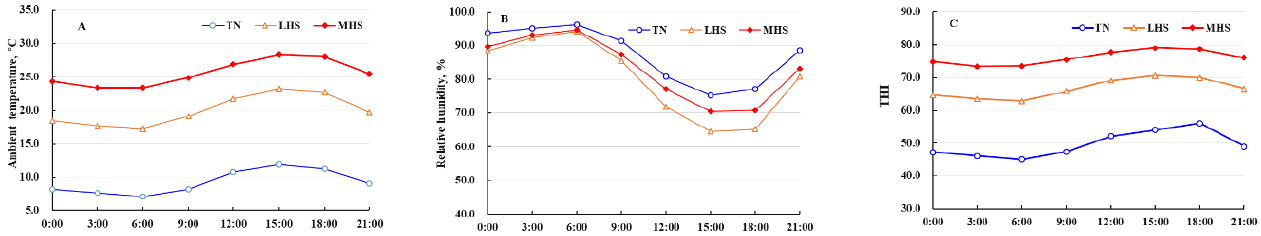
Figure 1. Ambient temperature ( A ), relative humidity ( B ), and temperature humidity indexes (THI) ( C ). TN = Thermal-neutral, LHS = Light heat stress, and MHS = Medium heat stress.